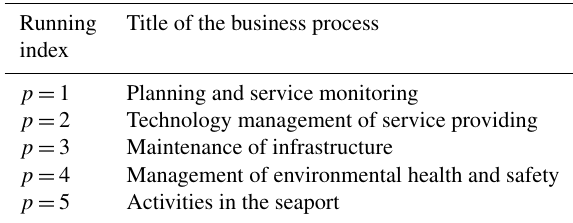
Table 1. Identified business processes in the